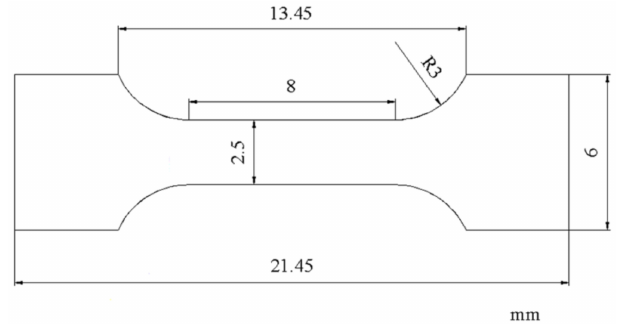
Figure 2. Geometric sketch of the tensile